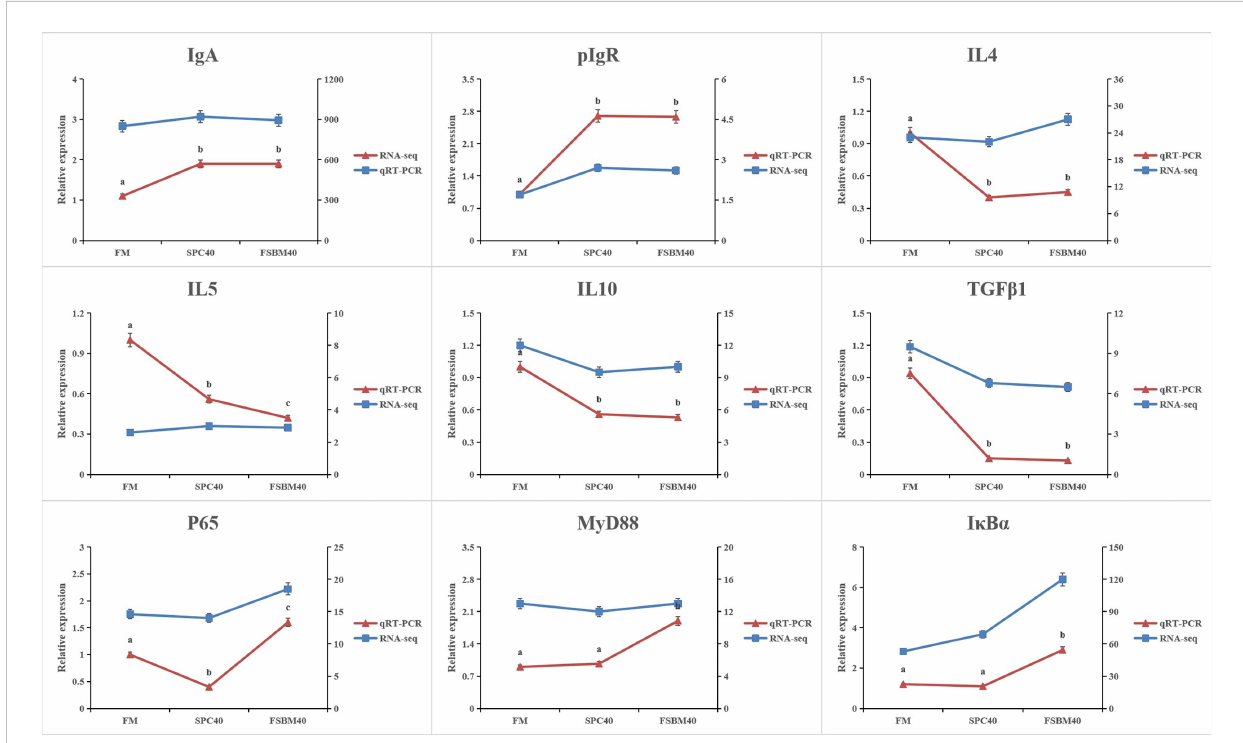
FIGURE 5 Comparison of RNA Seq and qRT-PCR results (n = 4). The mRNA expression level of qRT-PCR was normalized by b -actin . The relative expression level in RNA-seq analysis was calculated by FPKM value. Different letters assigned to the lines represented signi fi cant differences between the groups at P < 0.05.